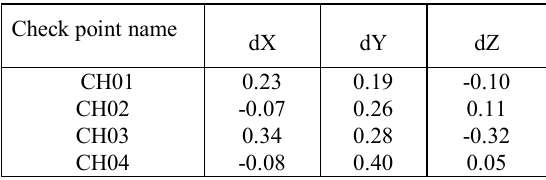
Table 3. Residual error of check points